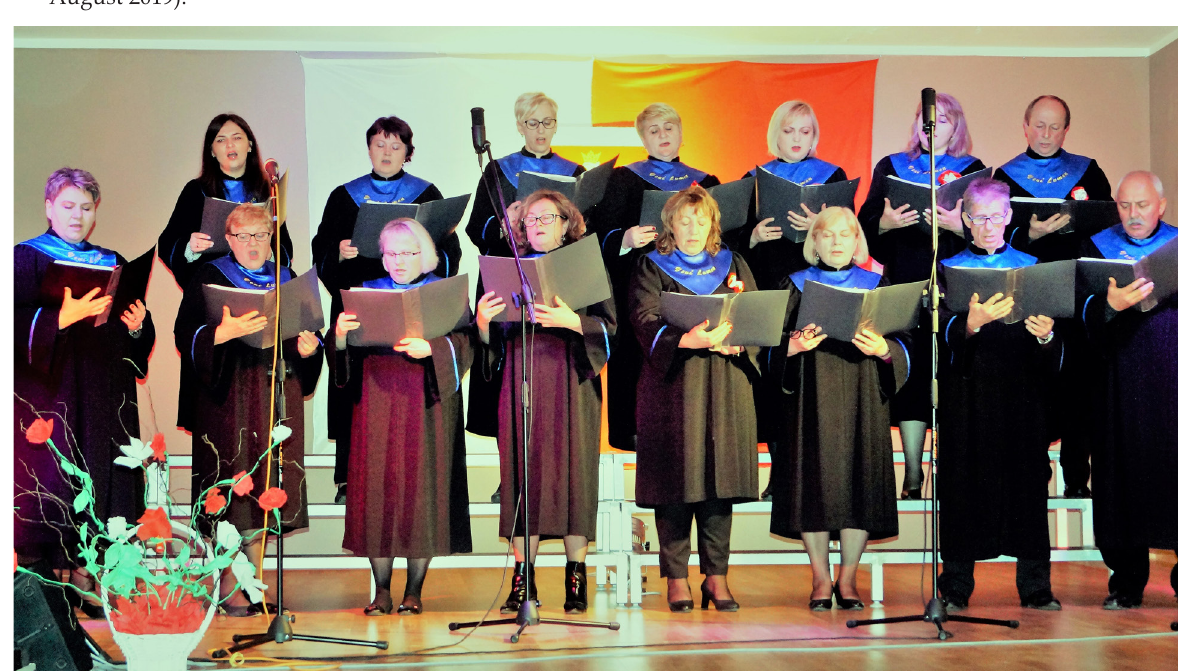
Fig. 7. The Veni Lumen choir at the commune cultural centre in Borek Strzeliński. Source: S. zawer/communal public library in